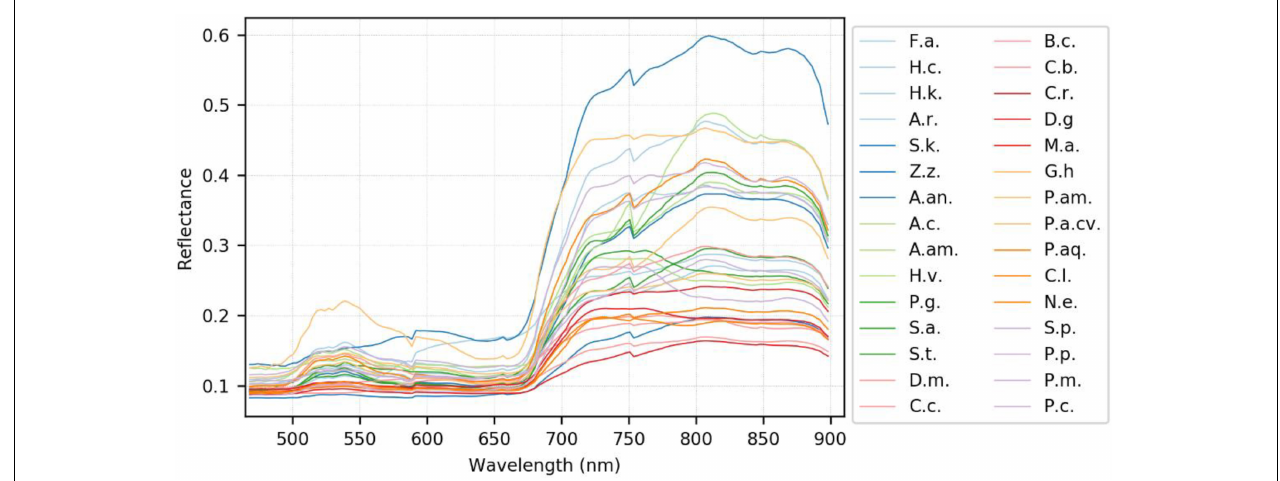
FIGURE 7 | The generalized reflectance curve of the plant species. Refer to Table 1 for the abbreviation of the species.